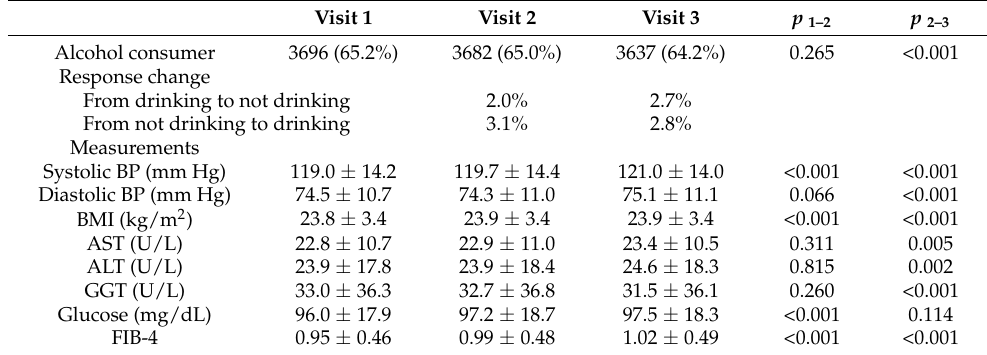
Table 2. Changes in the parameters related to liver